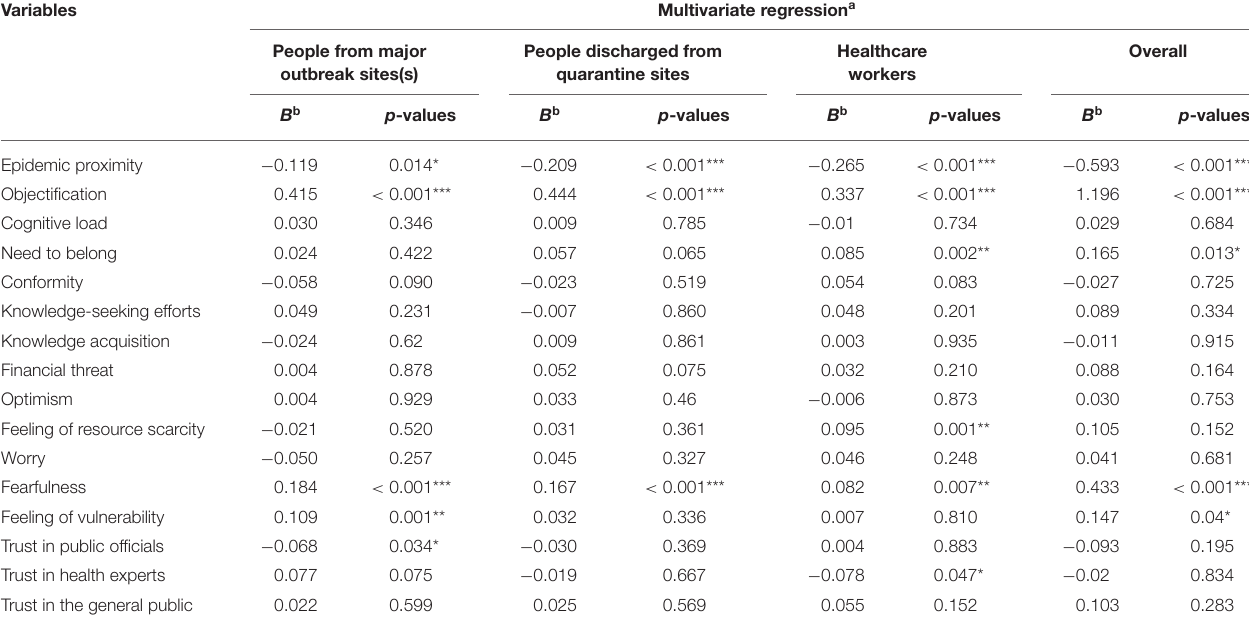
TABLE 2 | Variables associated with stigmatization and discrimination. Variables Multivariate regression